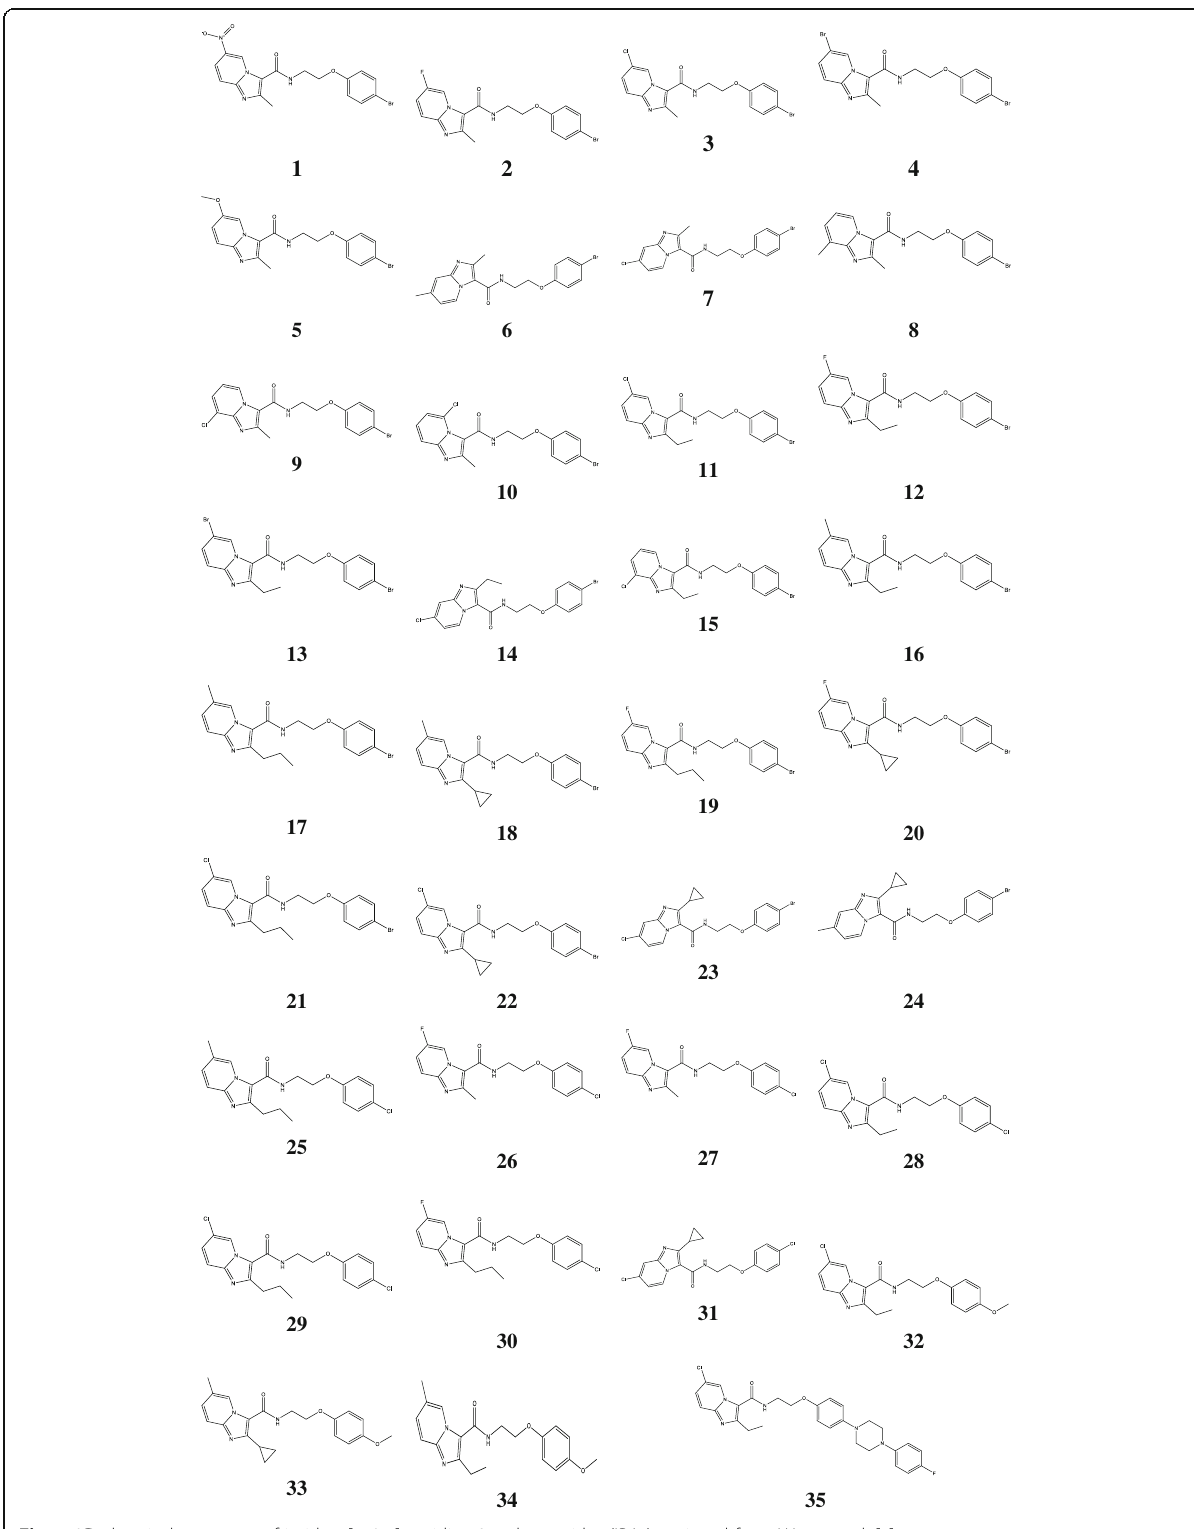
Fig. 1 2D chemical structures of imidazo[1, 2-a] pyridine-3-carboxamides (IPAs) retrieved from Wang et al.